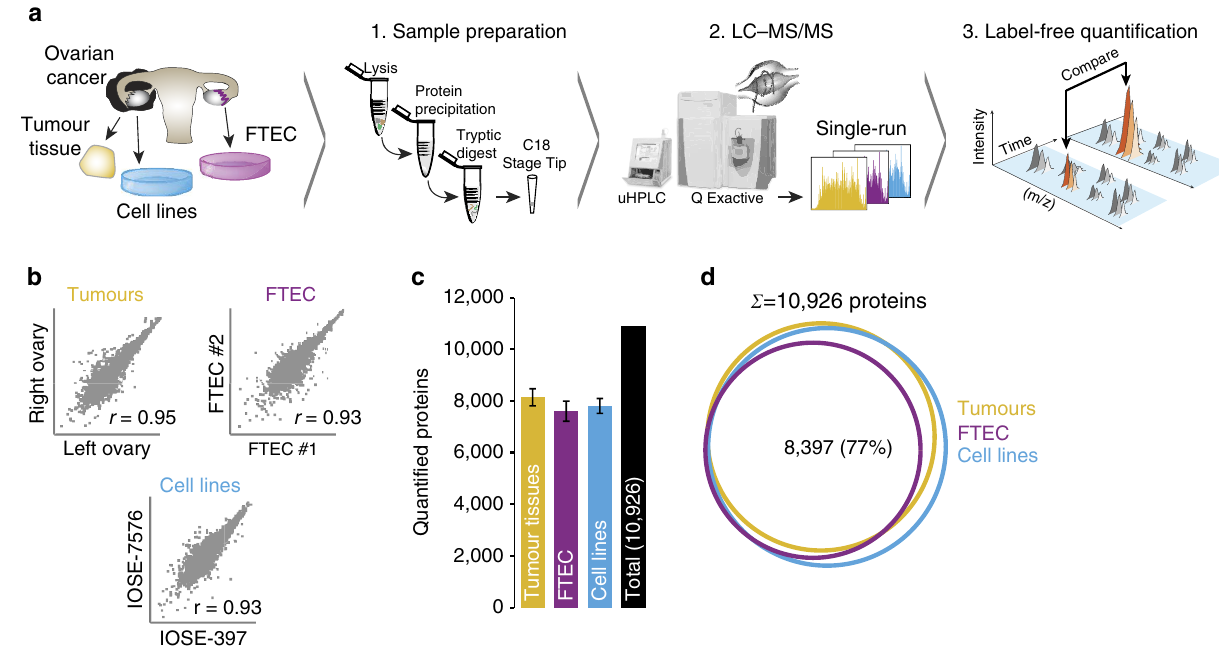
Figure 1 | Deep single-run proteomics of cell lines and human ovarian cancer tissue. ( a ) Summary of the shotgun proteomics workflow for OvCa cellular models and high-grade serous ovarian cancer (HGSOC) tissues. Following lysis, protein purification, and tryptic digest, peptides were separated by ultra-high performance liquid chromatography and measured in single runs using a quadrupole Orbitrap mass spectrometer. Label-free proteome quantification was performed using the MaxQuant software environment. ( b ) Workflow reproducibility for cell lines ( n ¼ 30), HGSOC tissues ( n ¼ 8) and primary FTEC cells ( n ¼ 3). Pearson correlations ( r ) were calculated for biological replicates of cell lines, primary FTEC isolates from different healthy donors, and ovarian tumour tissues from both ovaries from a woman with HGSOC. ( c ) Average number of quantified proteins from each sample type. Error bars represent standard deviations. ( d ) Number of proteins common to FTECs, HGSOC tumours and cell lines. FTEC, fallopian tube epithelial cell; LC-MS/MS, liquid chromatography tandem mass spectrometry; m/z , mass-to-charge ratio; uHPLC, ultra-high performance liquid across 30 cell lines. Average filtered quantification depth and